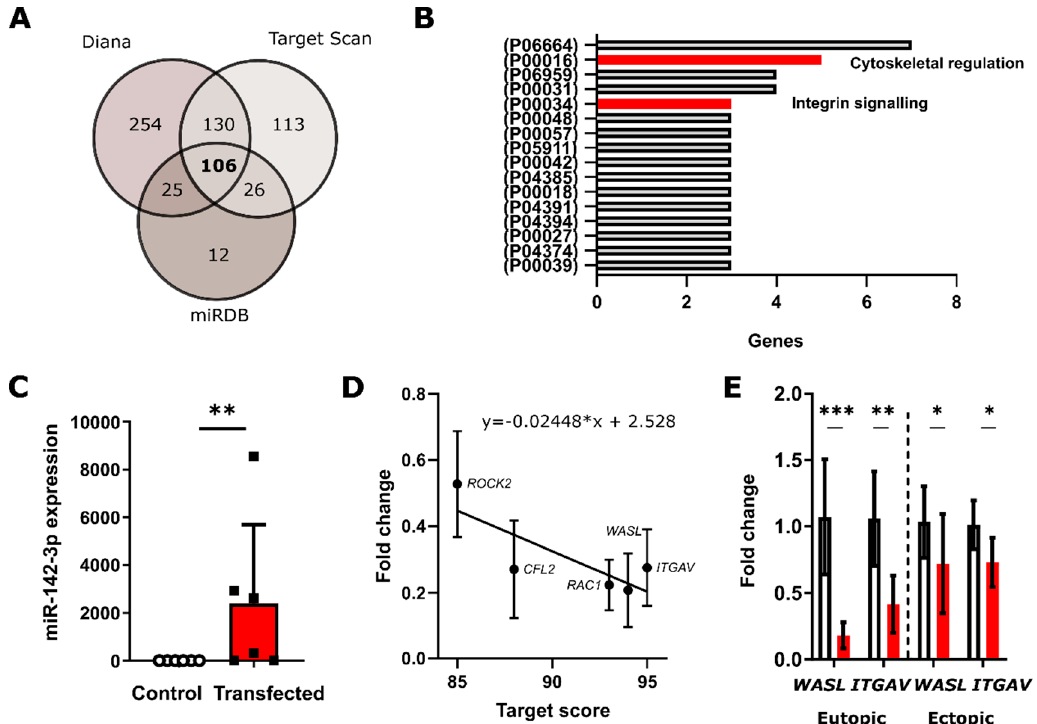
Figure 1. miR-142-3p targets multiple genes involved in the cytoskeletal regulation and integrin signaling pathways ( A ) Venn diagram depicting mRNA targets of miR-142-3p predicted by three independent algorithms Diana, Target Scan, and miRDB. ( B ) Pathways predicted by PANTHER that contain three or more predicted target genes of miR-142-3p. The codes can be looked up in the panther database. ( C ) qPCR analysis of miR-142-3p transfected St-T1b cells ( n = 6, t -test). ( D ) qPCR identified that the predicted gene products ROCK2 , CFL2 , RAC1 , WASL , and ITGAV are significantly downregulated in St-T1b compared to controls ( n = 3, t -test) and that the degree to which they are downregulated correlates with the predictions of the miRDB algorithm (y = − 0.02448*x + 2.528). ( E ) The targets WASL and ITGAV are downregulated by miR-142-3p both in eutopic (eut) (uterine) and ectopic (ect) primary endometrial stromal cells (ESCs) white bars represent control cells and red bars transfected cells ( WASL : p eut = 0.0006, p ect = 0.0277, n eut = 6, n ect = 13, ITGAV: p eut = 0.0035, p ect = 0.0234, n = 6, t -test). Data in the whole figure panel represent mean ± s.d. For all figures in this panel * p < 0.05; ** p < 0.01; *** p < 0.001, and n.s. p > 0.05.